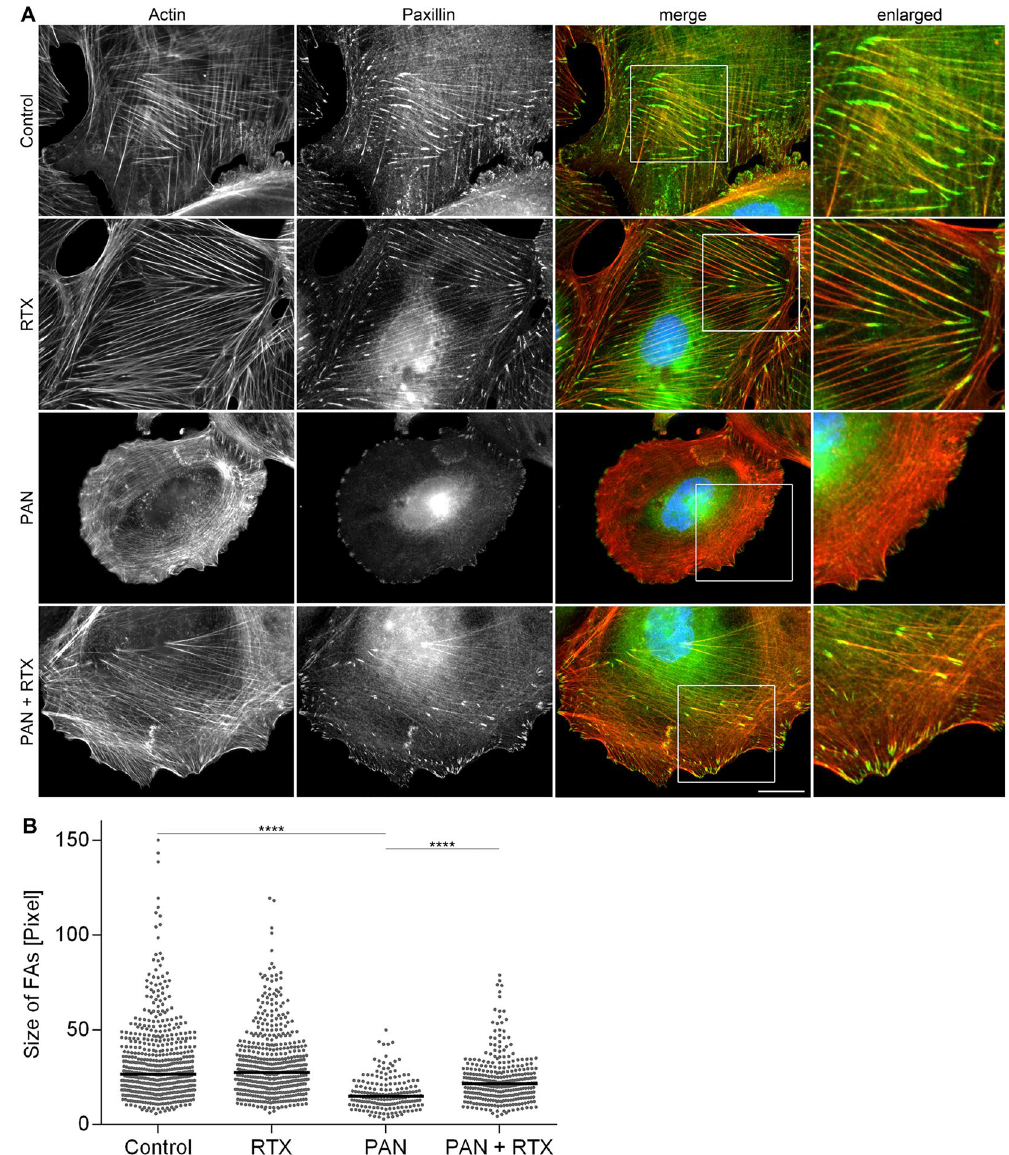
Figure 6. Aberrant size of focal adhesions is recovered by rituximab in human podocytes. ( A ) Actin (phalloidin-TRITC) and paxillin staining images are presented in gray scale for maximum contrast. The merge image depicts paxillin in green and actin in red. DAPI was used to visualize nuclei (blue). Scale bar = 25 µm. ( B ) Quantification of focal adhesion size. Statistics: One-way ANOVA with Tukey’s multiple comparisons test; the median is shown, one dot represents the length of one focal adhesion. ****p < 0.0001; n = 3 experiments; ≥ 200 focal adhesions per condition. FAs = focal adhesions; RTX = rituximab (100 µg/ml); PAN = puromycin aminonucleoside (30 µg/ml). Treatment time: 48 h.